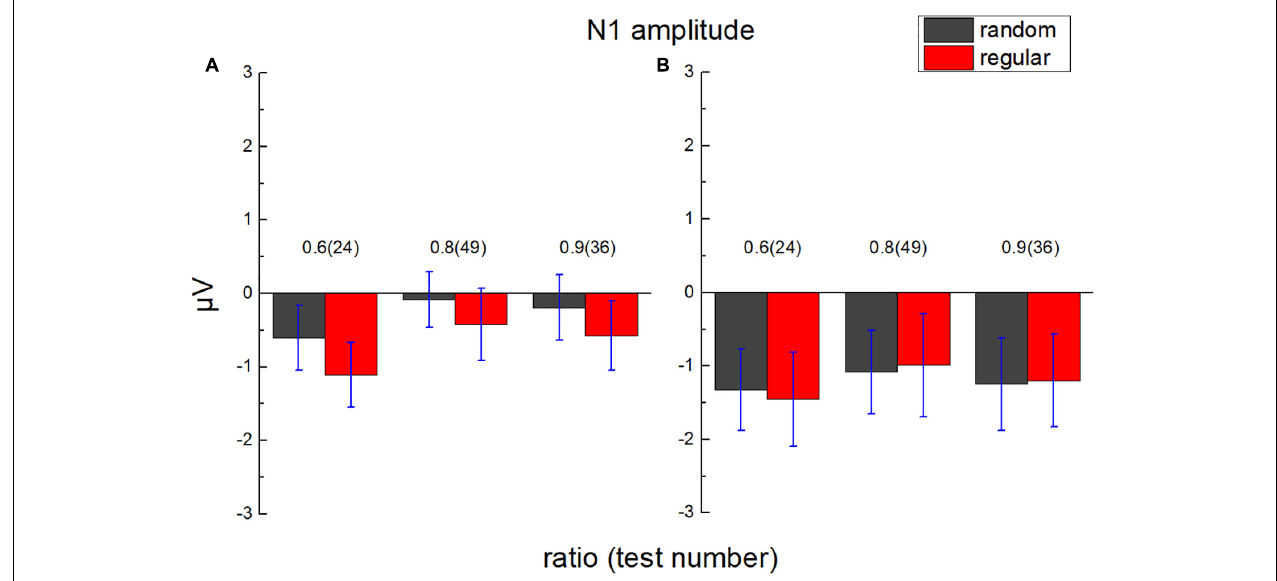
FIGURE 7 | Average N1 amplitude in the parietal lobe and the occipital lobe. (A) The average amplitude of ERP of participants in the parietal lobe from 135 to 165 ms after test presentation (N1) is demonstrated according to different test ratios (0.6, 0.8, and 0.9). (B) N1 in the occipital lobe. Black bars stand for the randomly distributed patterns, and red ones stand for the regularly distributed patterns. Error bars denote 1 SE of the mean.